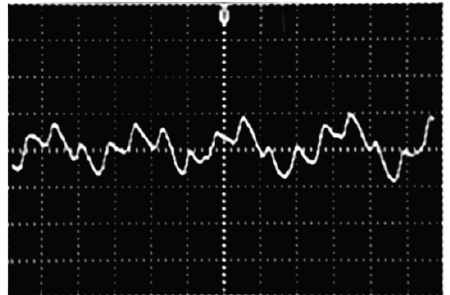
Figure 9. Composite signal with the respiratory rate and the heartbeat.